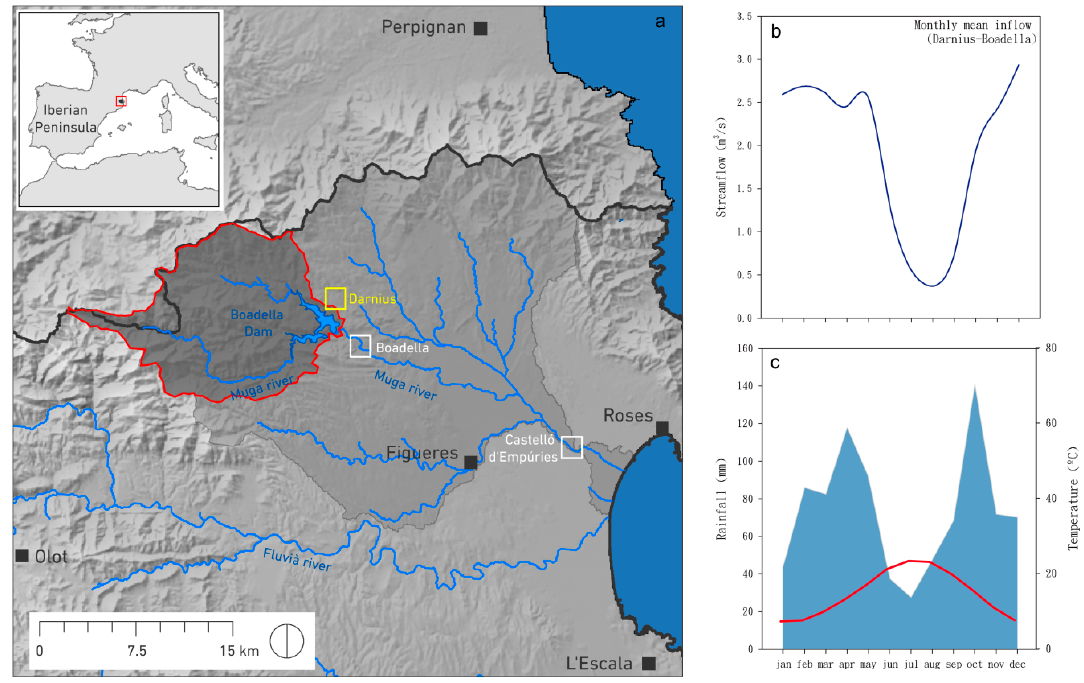
Figure 1. ( a ) Study area; ( b ) monthly mean inflow in Darnius-Boadella dam; ( c ) ombroclimatic